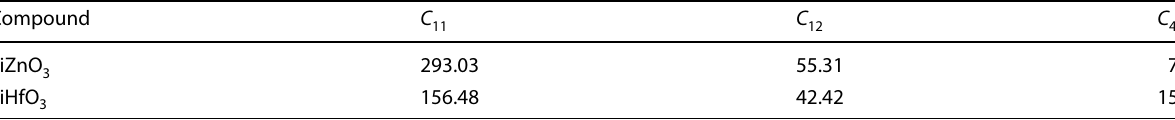
and LiHfO compound 3 3